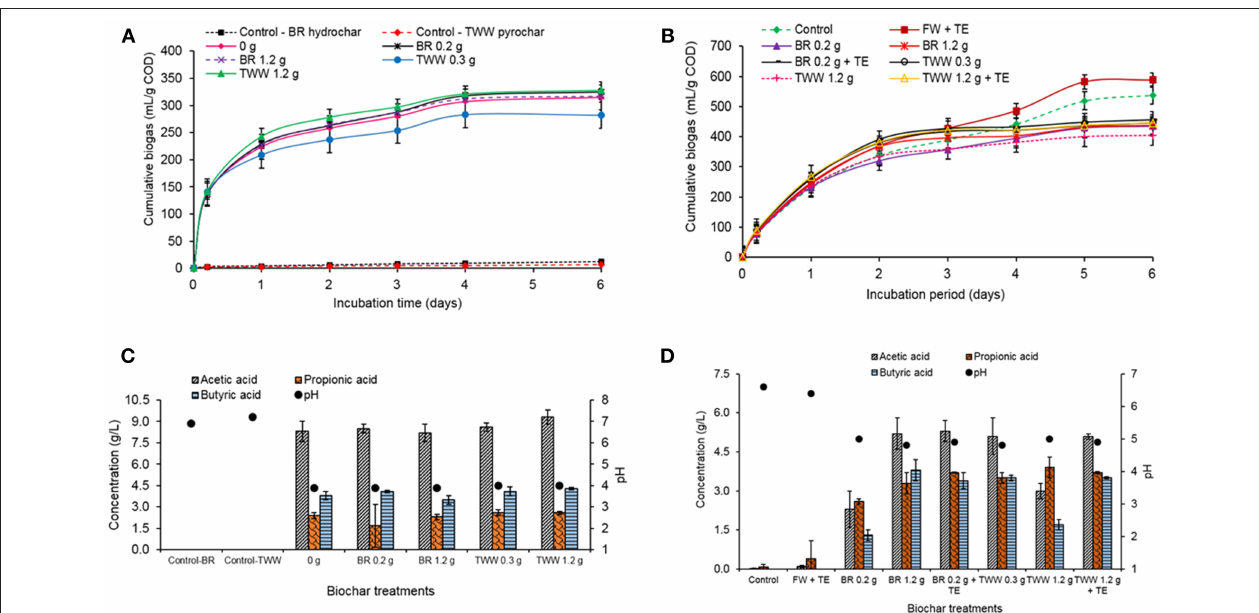
FIGURE 5 | (A) Cumulative biogas production during the treatment with different doses of the brewery residue (BR) hydrochar and the treated waste wood (TWW) pyrochar, with 1M NaHCO 3 , (B) Cumulative biogas production during treatment with the brewery residue hydrochar and the treated waste wood pyrochar (FW, food waste; TE, trace element; BR, brewery residue; TWW, treated waste wood), with 1M NaHCO 3 , (C) VFA production in the treatments with different doses of the brewery residue (BR) hydrochar and the treated waste wood (TWW) pyrochar (incubation period: 6 days), with 1M NaHCO 3 , and (D) VFA production in the treatments with the brewery residue hydrochar and the treated waste wood pyrochar (incubation period: 6 days; FW, food waste; TE, trace element; BR, brewery residue; TWW, treated waste wood), with 1M NaHCO 3